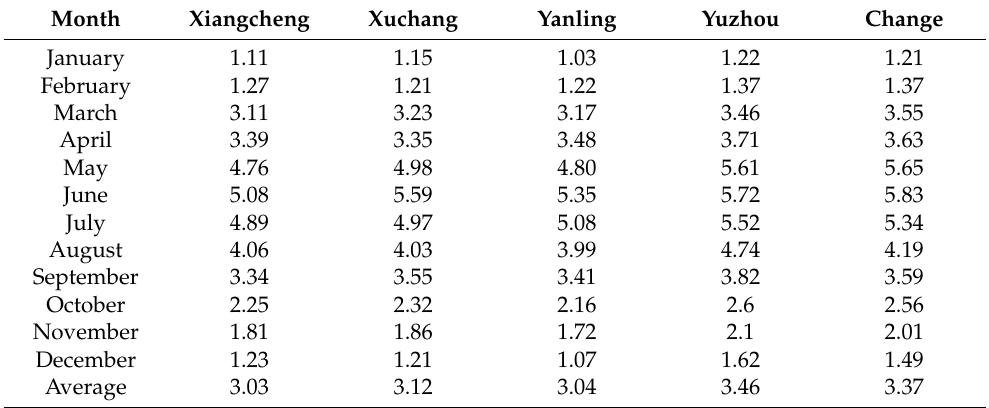
Table 2. Monthly reference evapotranspiration ET 0 /(mm day − 1 ) under the hydrological year type ( p = 50%).